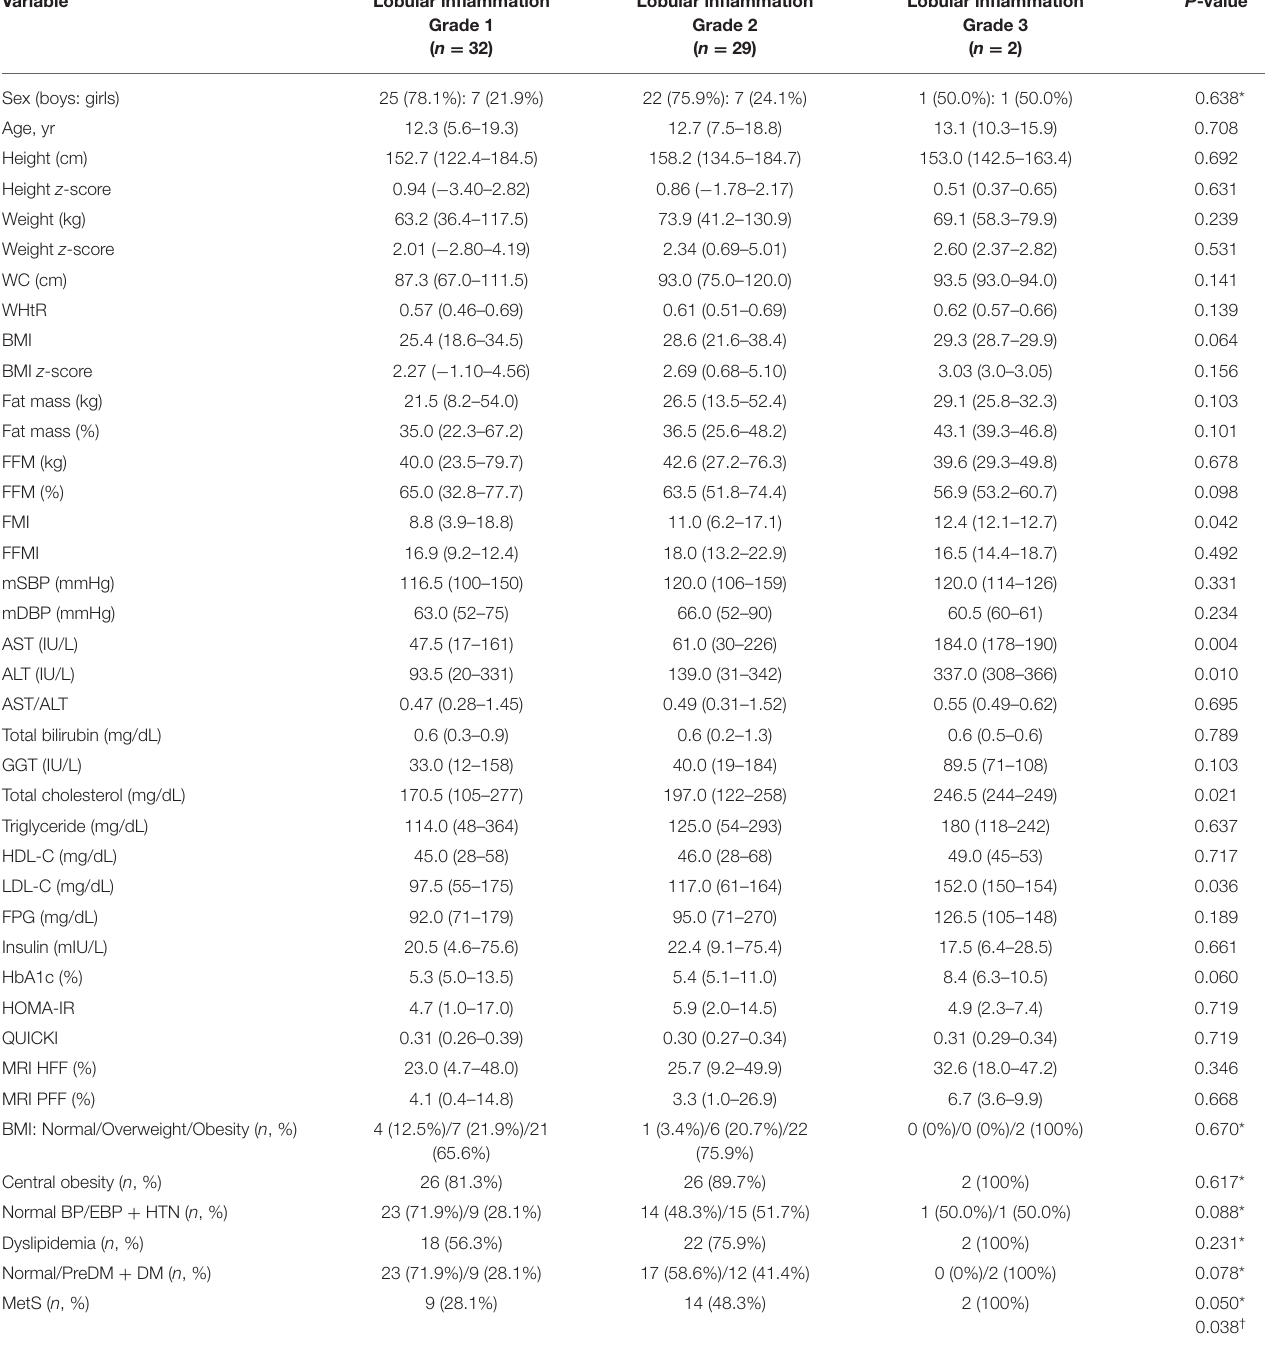
TABLE 3 | Comparison of demographic, anthropometric, laboratory, and magnetic resonance imaging-measured fat fraction findings of 63 children with non-alcoholic fatty liver disease by liver histologic lobular inflammation